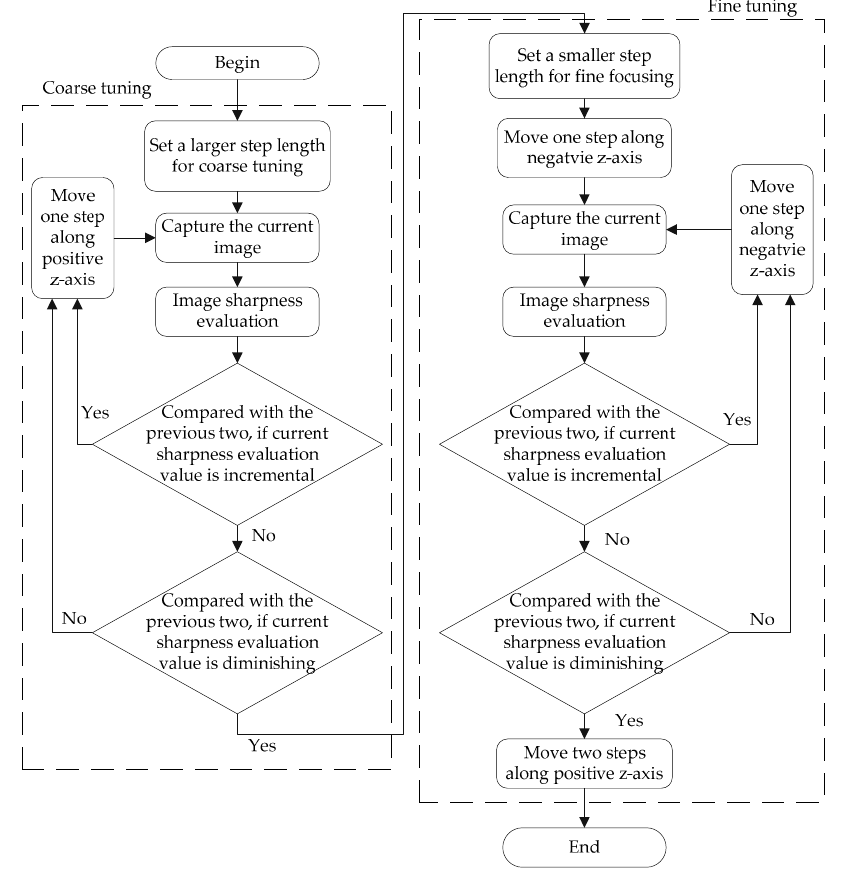
Figure 5. Control method schematic of the entire automatic focusing process.